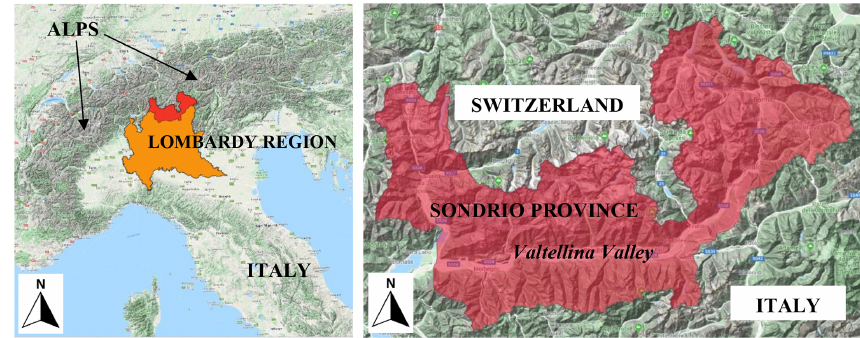
Figure 1. Case study area of Sondrio Province, northern Lombardy; base layer from © Google Maps